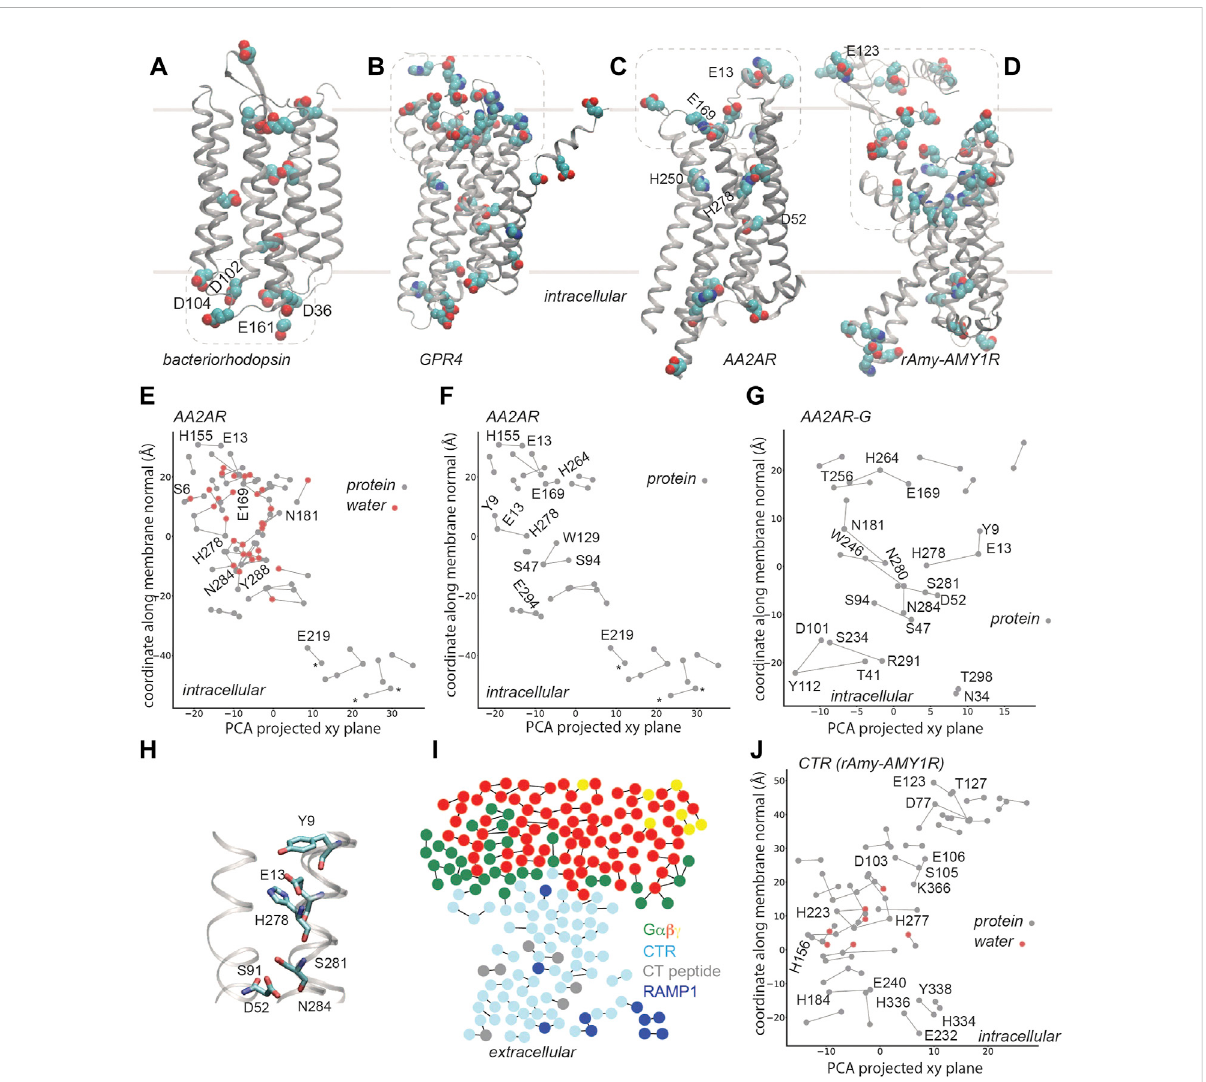
FIGURE 2 H-bond networks of GPCRs. Dotted lines indicate selected clusters of bulk-exposed carboxylic and His groups. (A) Carboxylic groups of bacteriorhodopsin, based on pdb 5zim [81]; Asp/Glu groups labeled are part of theproton-collecting antenna[37, 38]. (B) Carboxylic and His groups of human GPR4 from model AF-P46093-F1-model_v2, UniProt entry P46093 [61]. (C,D) Carboxylic and His groups of AA2AR (panel B, pdb 5nm4, 1.7Å resolution [63]) and of rAmy-AMY1R (pdb 7tyf [72]). (E – G) C-Graphs H-bond graphs computed with water bridges (E) vs. for protein sidechains (F) forAA2ARbasedonpdb5 nm4,andforG-proteinboundAA2AR,pdb5g53,3.4 Åresolution[82] (G) .H-bondnetworksofAA2ARswere reported in Refs. [19, 21]. In panels (E,F) , stars indicate groups of a synthetic construct. (H) Selected H-bonds of AA2AR. (I) Bridge2 H-bond graph of the CTR-G protein complex, pdb 6e3y, 3.3 Å resolution [70]. (J) C-Graphs H-bond graph for the CTR, pdb 7tyf, 2.2 Å resolution [72]. Panels (E – G,J) use structures with the receptor domain oriented along the membrane normal using VMD and OPM